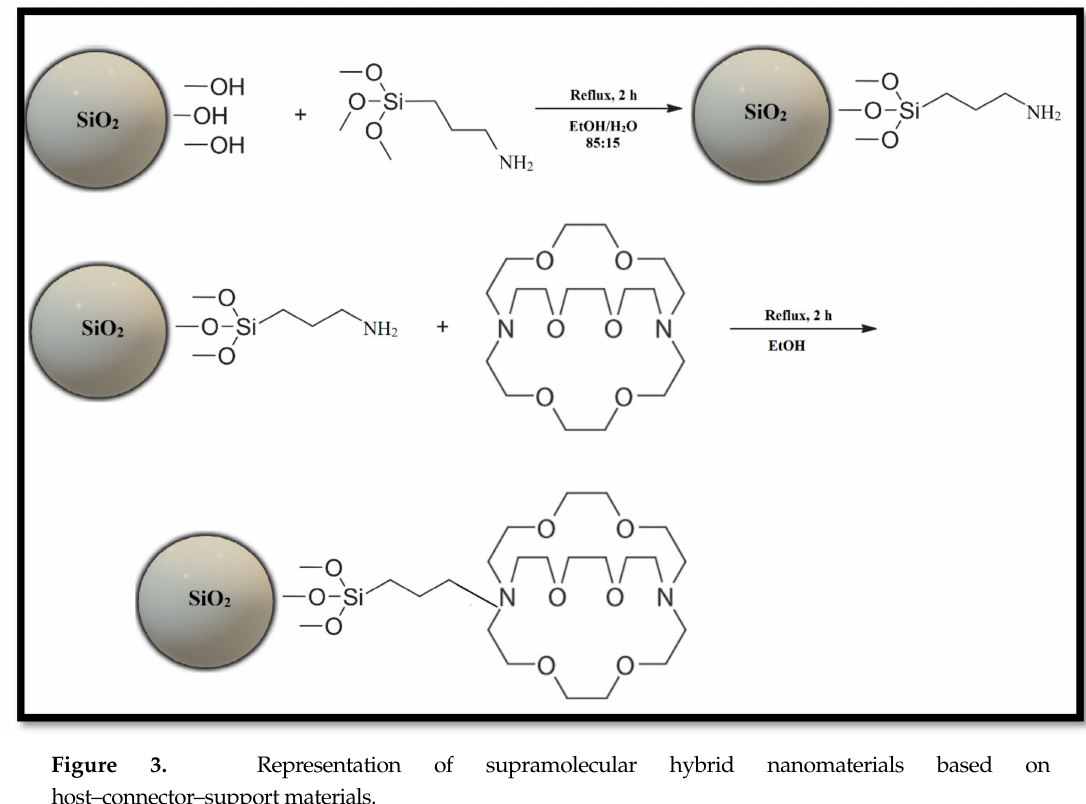
Figure 3. Representation of supramolecular hybrid nanomaterials based on host–connector–support